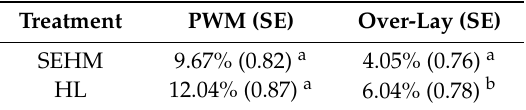
Table 1. Comparison of average (standard error; SE) pre-weaning mortality (PWM) and over-lay (OL) percentage between semi-enclosed heated microclimate (SEHM; n = 113) and heat lamp (HL; n = 101) for six farrowing cycles. Levels not connected by the same superscript letter are significantly di ff erent ( α = 0.05).